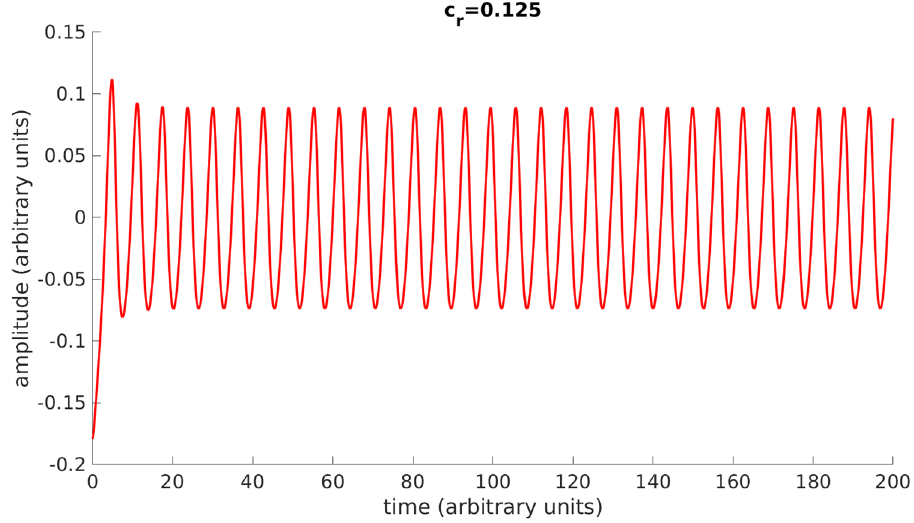
Figure 6. The amplitude and phase of a single mode for c r = 0.125